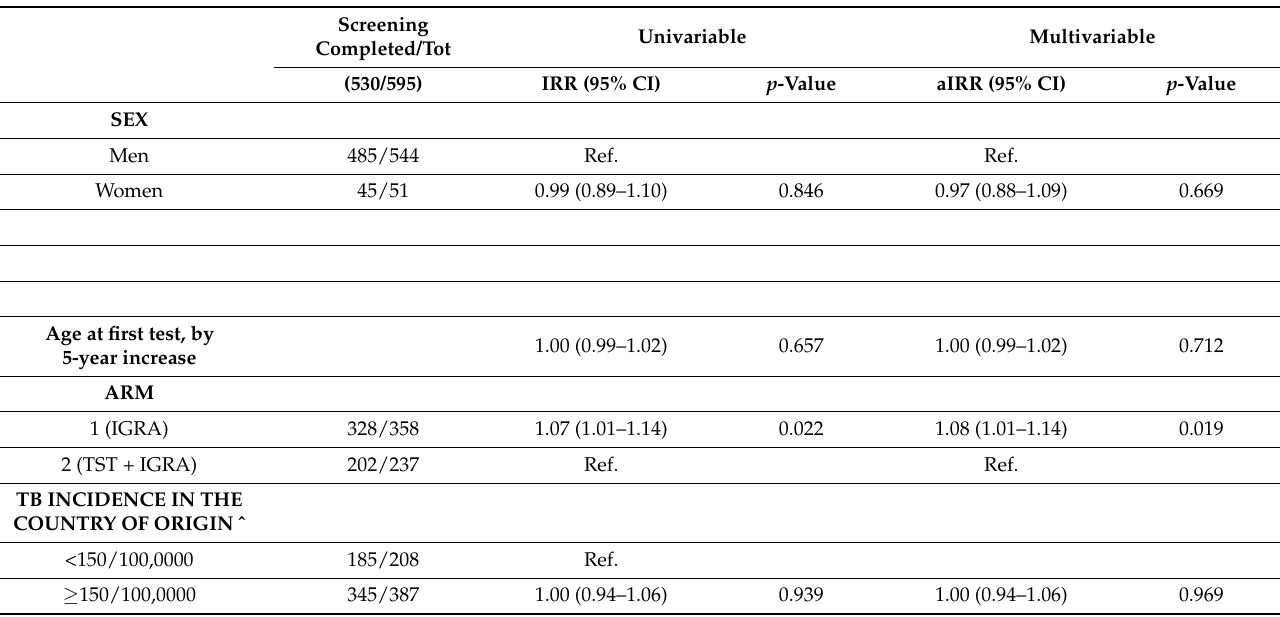
Table 2. Incidence rate ratio (IRR) and 95% confidence intervals (CIs) for screening